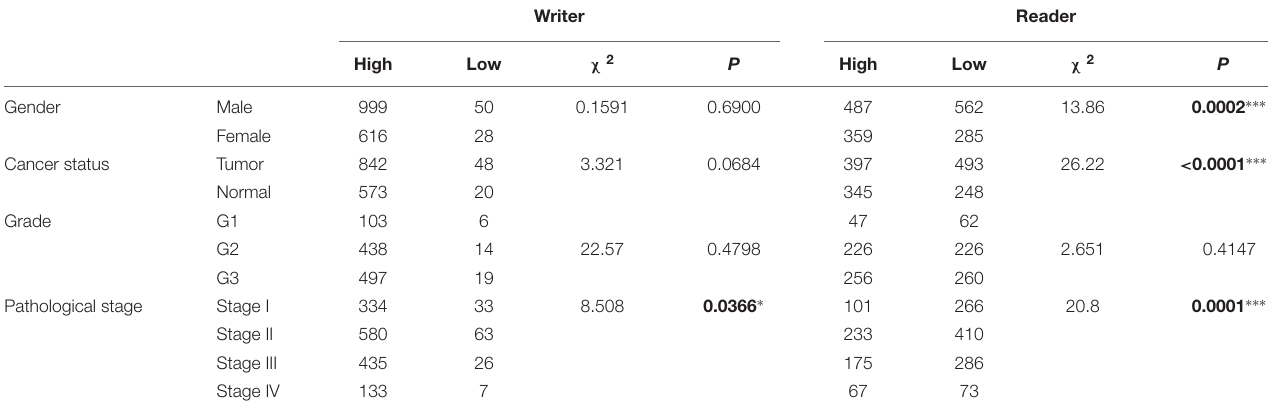
TABLE 1 | Association of m 5 C mRNA expression with clinicopathological parameters of GI cancer